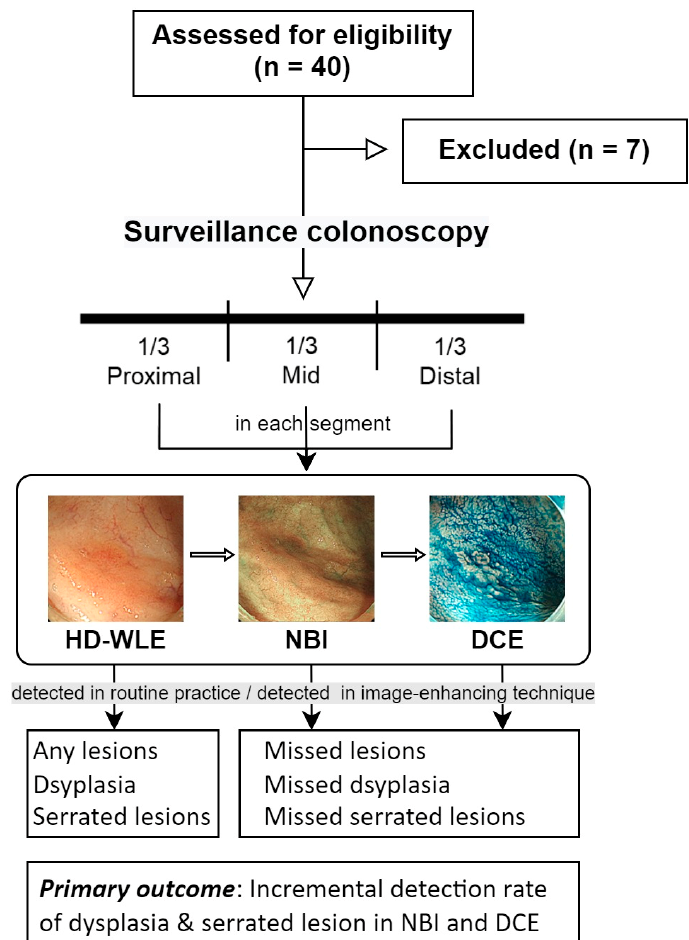
Figure 1. Study flow diagram. HD-WLE, high-definition white-light endoscopy; NBI, narrow-band imaging; DCE, dye spray chromoendoscopy.